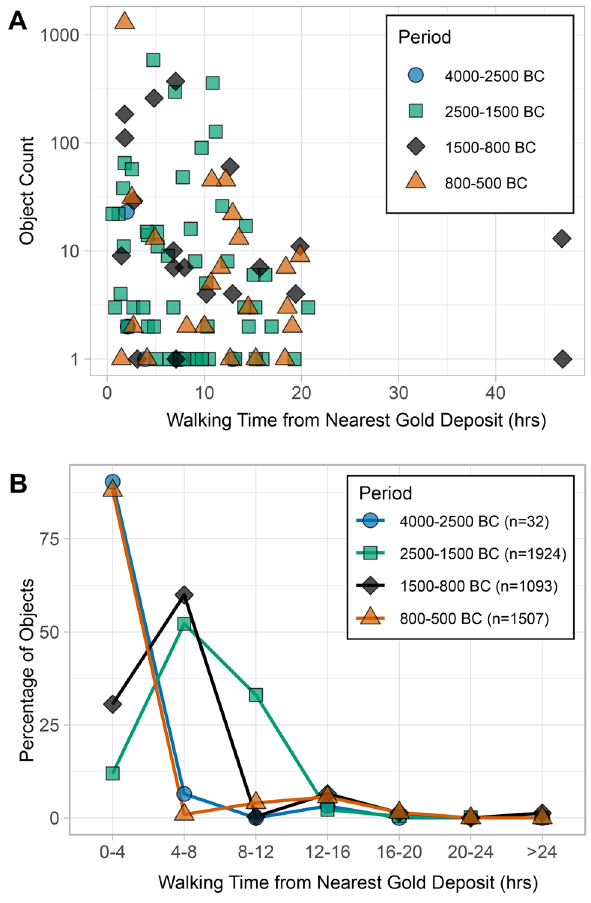
Figure 5. ( A ) Log-scale plot of object numbers vs. least cost walking time to nearest ore deposits, for each period at each site. ( B ) Log-scale plot of percent of objects (of the total number for each period) vs. distance from ore deposit, binned in 4-h increments of least cost walking time from the nearest deposit.